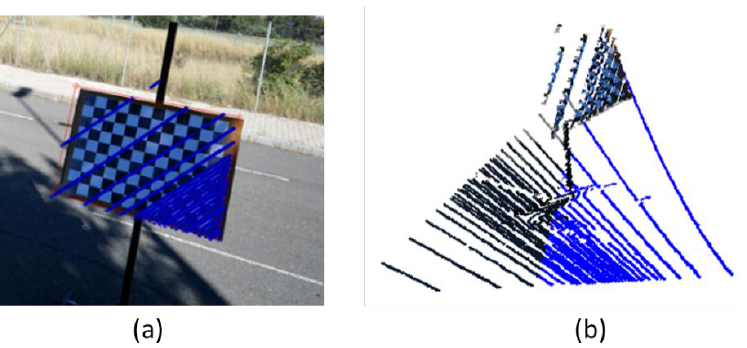
Figure 9. Camera-LiDAR calibration. ( a ) backward projection of point clouds on the image. ( b ) forward projection of the image pixel on the point cloud.